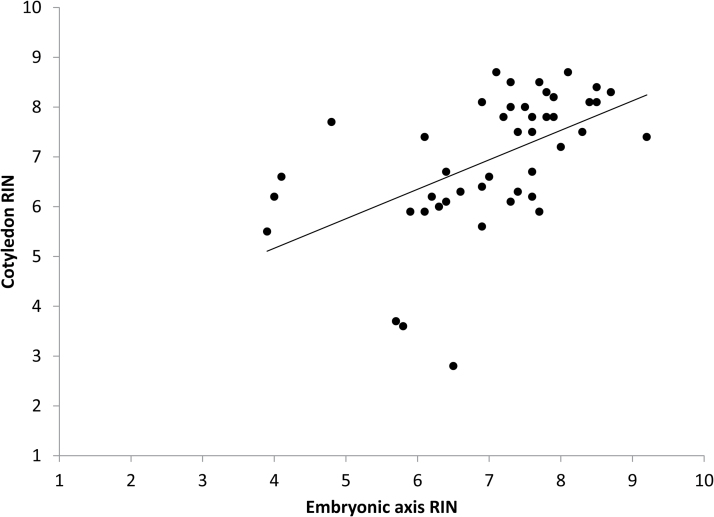
Correspondence of RIN values measured for cotyledons and embryonic axes of soybean seeds stored for up to 27 years. Each data point (x,y pair) represents an individual seed from one of 10 age cohorts harvested between 1989 and 2015. The correlation is positive: cotRIN=2.798 + 0.592×embryo RIN (n=48, df=47, R2=0.28, F=11.4, P=0.002).